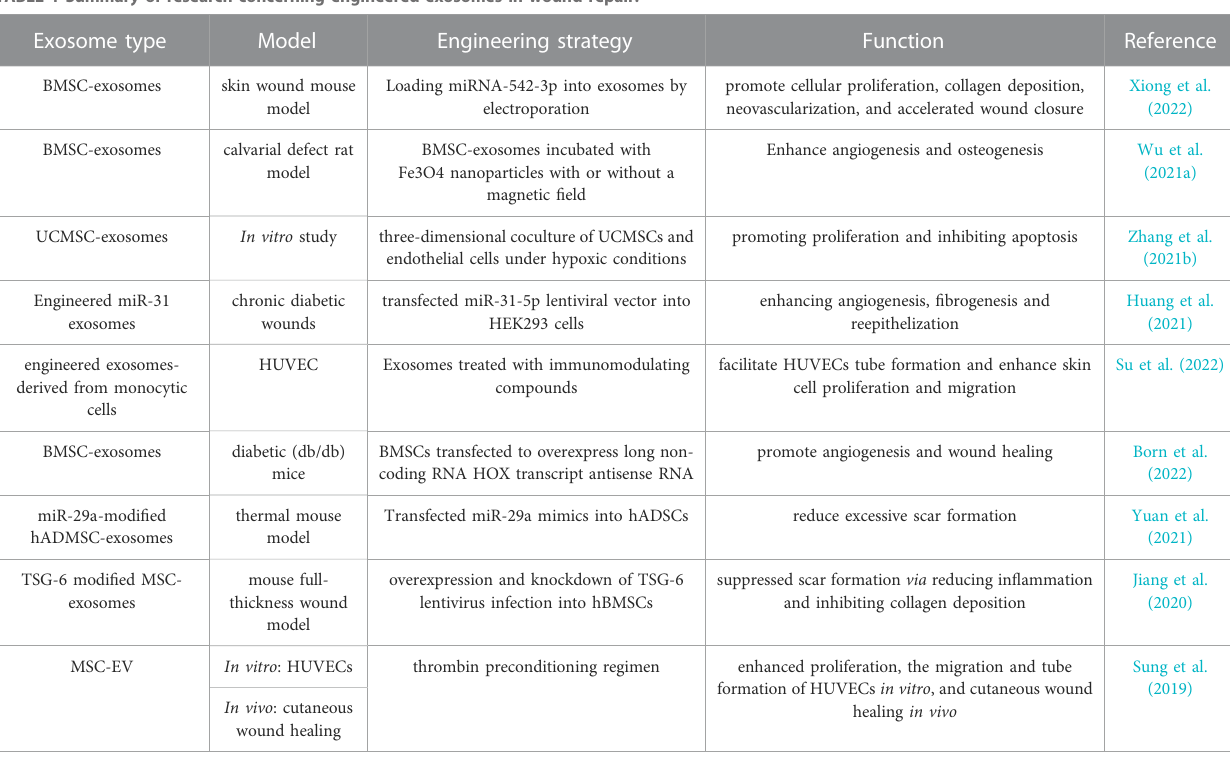
TABLE 1 Summary of research concerning engineered exosomes in wound